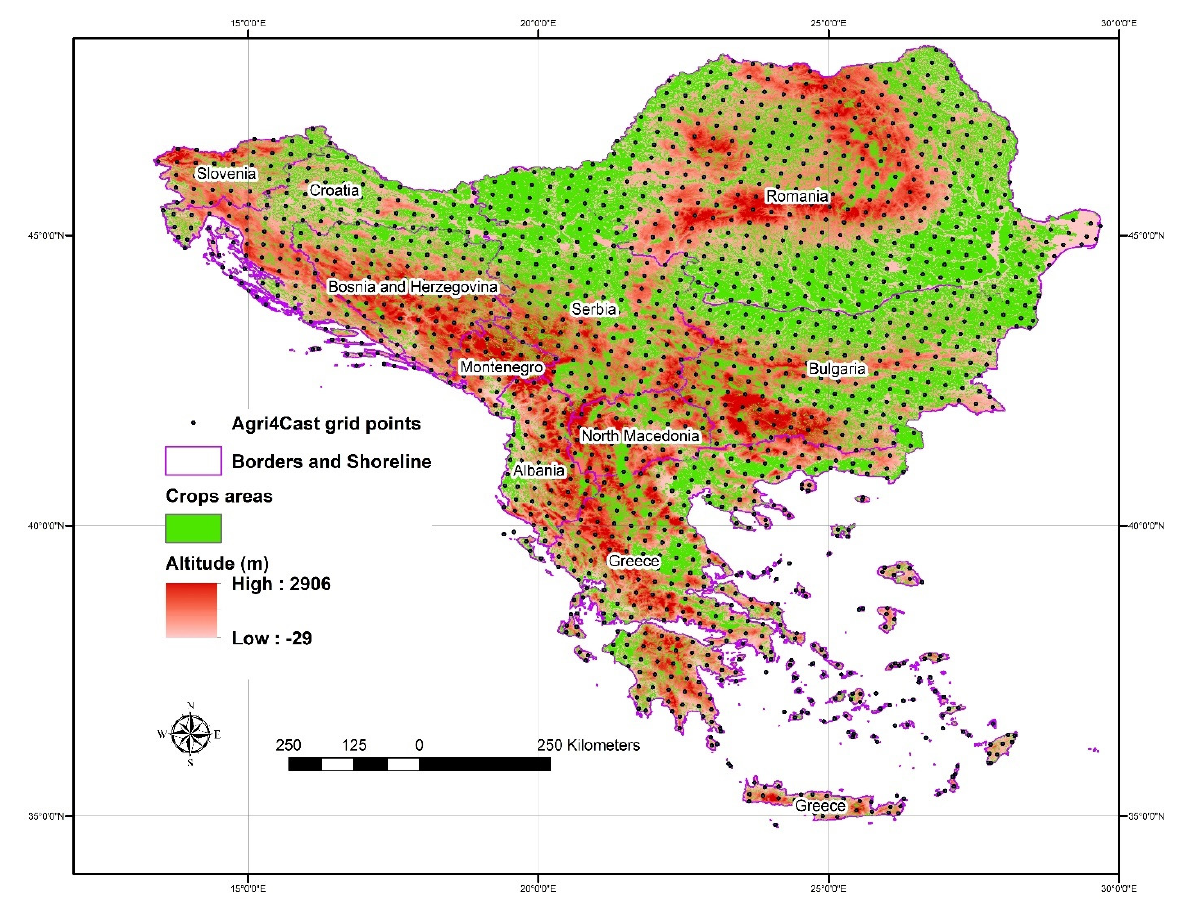
Figure 1. The study area with the Agri4Cast grid points and the potential crops are from Corine Land Cover (CLC) 2018 dataset.